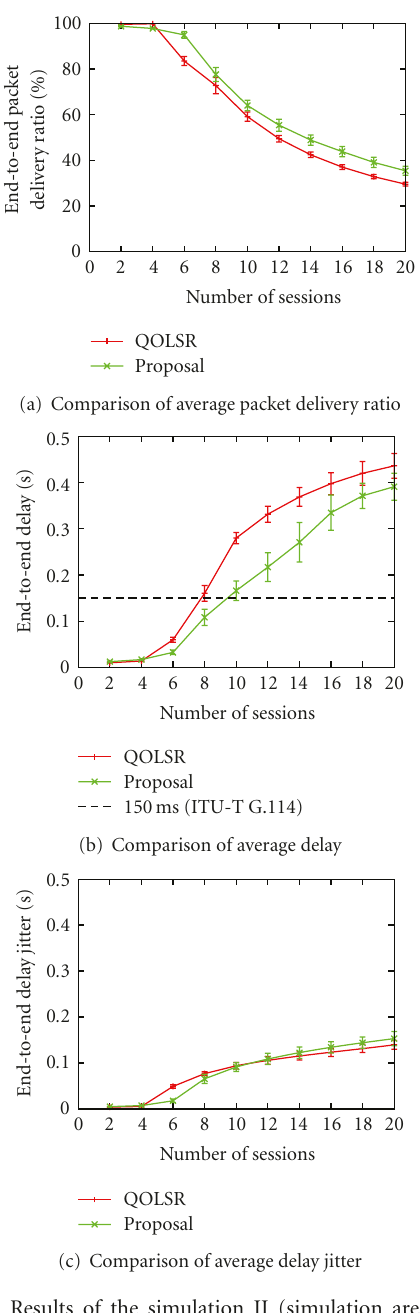
Figure 9: Results of the simulation II (simulation area: 6000 × 6000 m, number of nodes: 100, broadcast rate: 12 Mb/s, packet size: 1292 bytes).